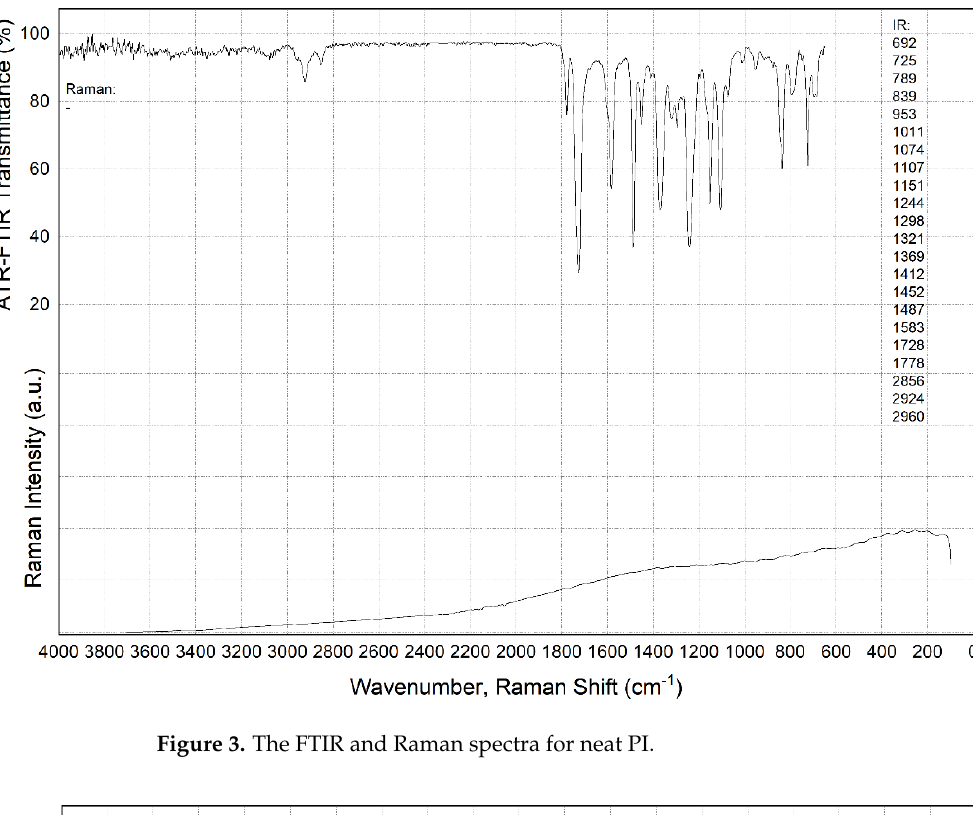
Figure 2. SEM micrographs of the structure of the PI- and PEI-based composites: PI/CF100 ( a ); PEI/CF100 ( b ); PI/CF200 ( c ); PEI/CF200 ( d ); PI/CF2000 ( e ); PI/CF2000 ( f ). The specimen designations are presented in Table 2, below.